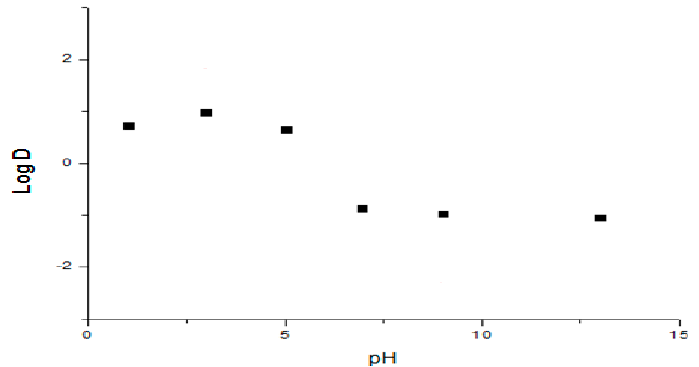
Figure 3. Log D of Compound 1 dependent on pH.